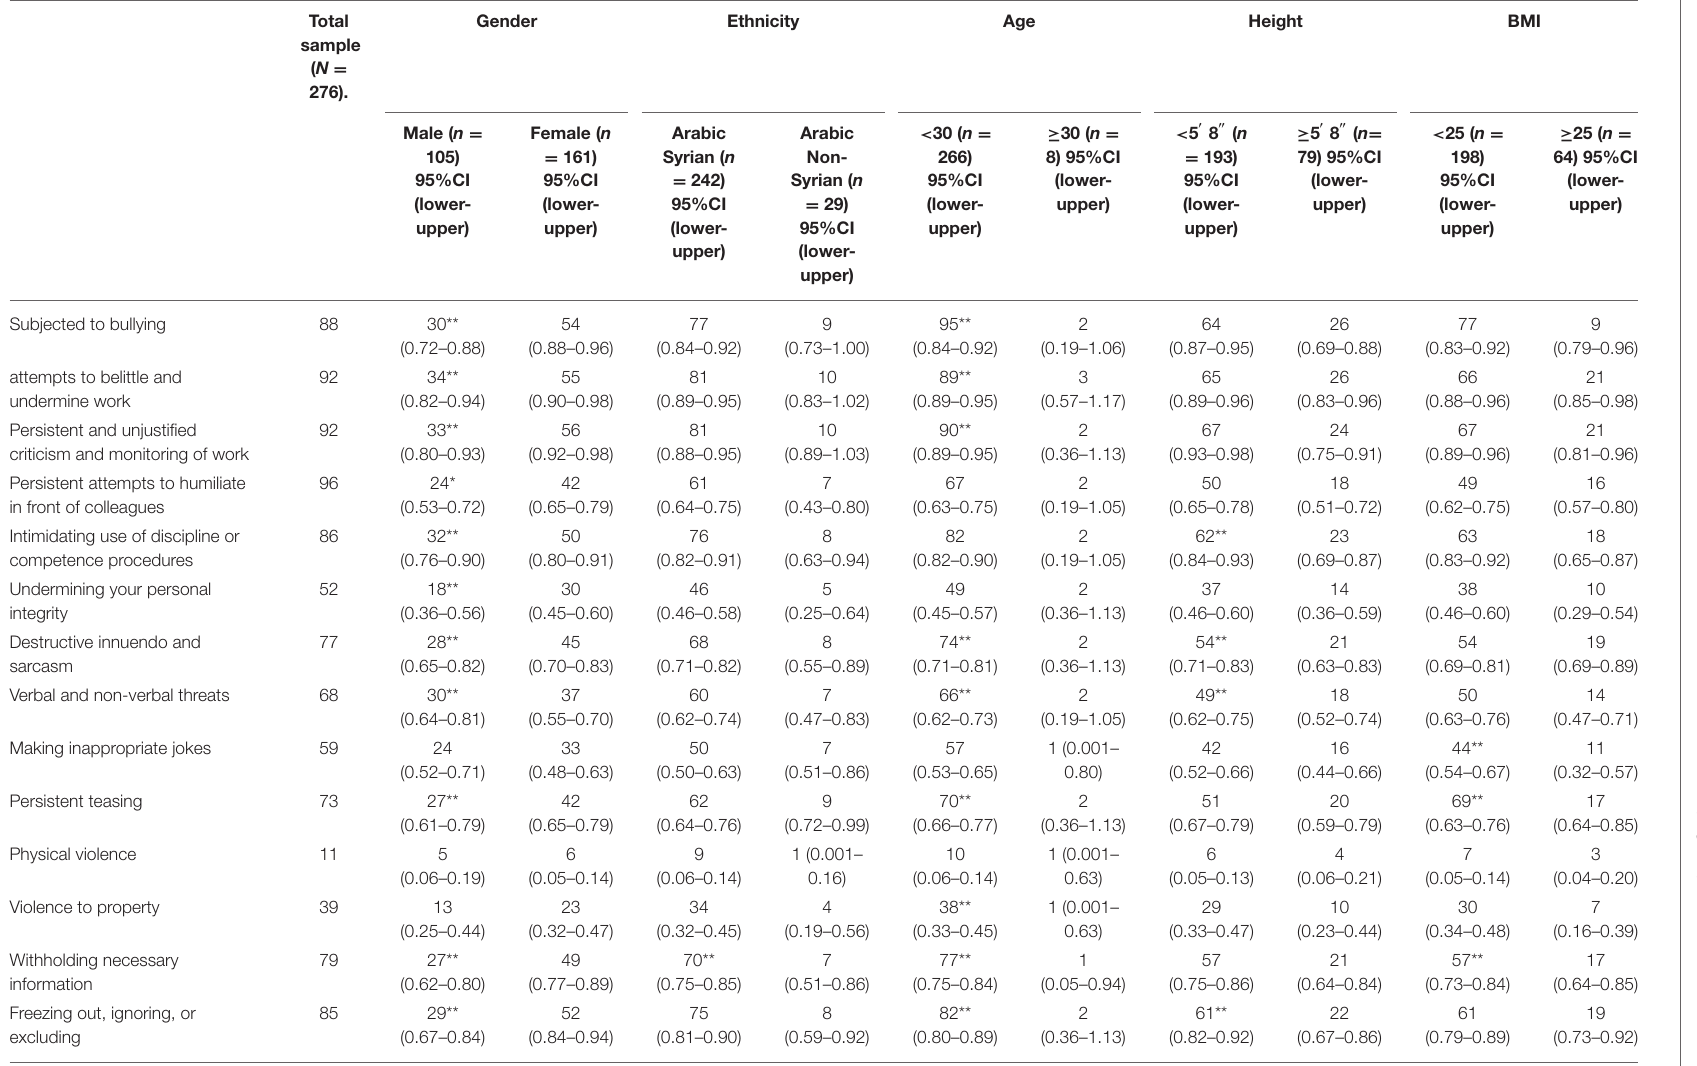
TABLE 3 | Percentages of bullying behaviors experienced by personal